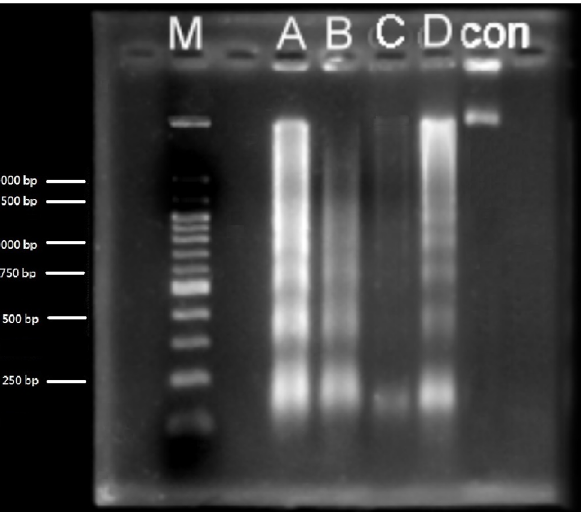
Fig 4. The DNA electrophoresis of Hep G2 cells after treatment with ACE polysaccharides, ACE/CS and ACE/S for 48 h. Hep G2 cells were seeded at the density of 2.0 × 10 5 cells/mL in 10-cm dishes. After different treatments, cells were harvested, lysed and centrifuged at 14,000× g for supernatant collection. The fragmented DNAs were extracted, analyzed with 2% agarose gel electrophoresis containing 0.1 μ g/mL ethidium bromide and imaged. Experiments were repeated 3 times independently to ensure reproducibility. M: Maker, A: 25 μ g/mL ACE polysaccharides, B: ACE/CS (ACE polysaccharides = 13.2 μ g/mL), C: